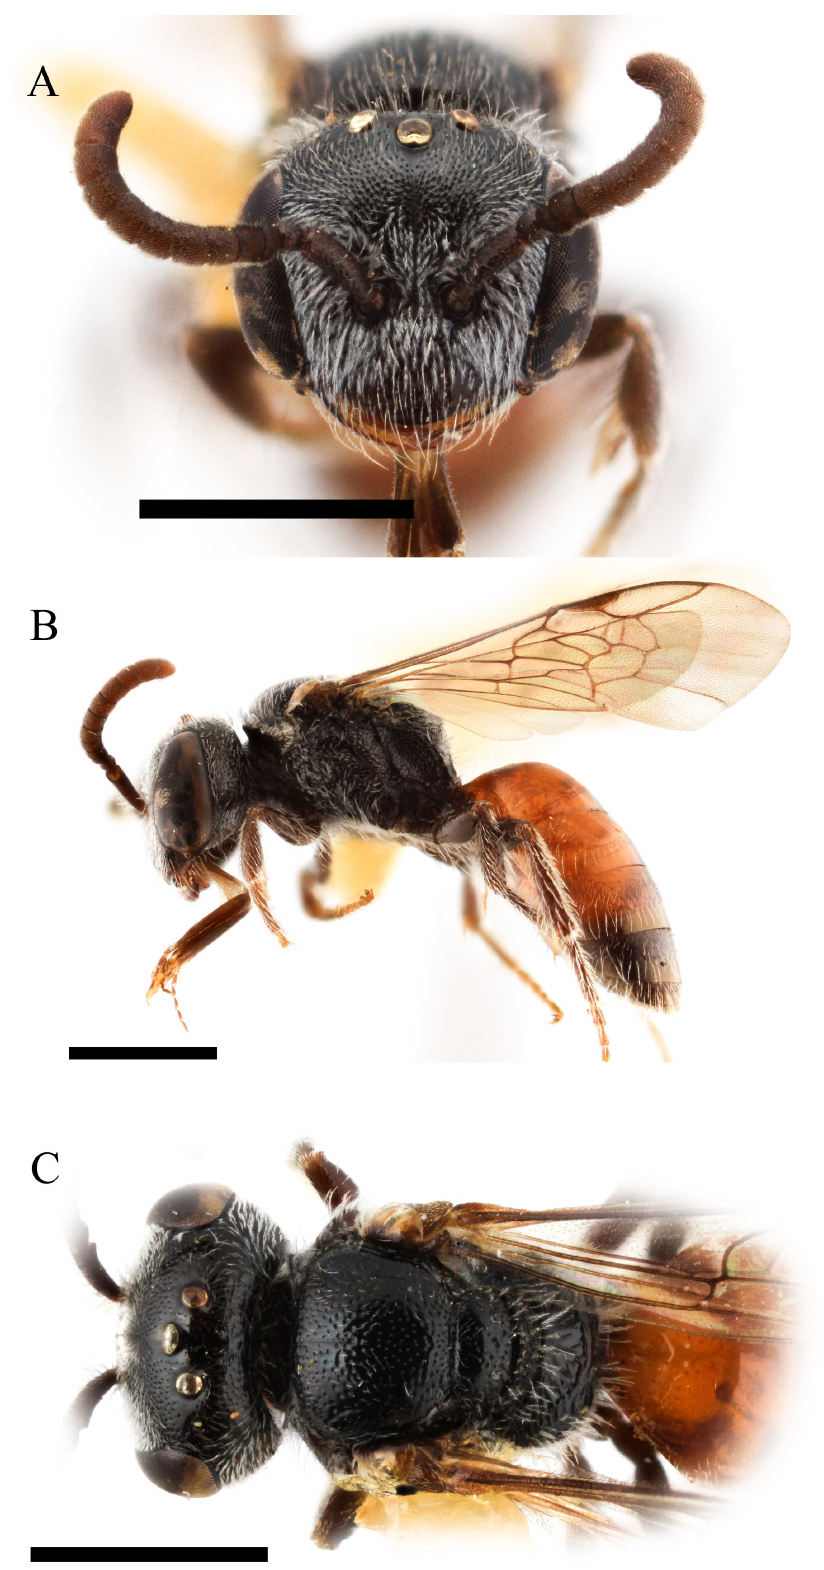
Fig. 12. Sphecodes albifacies sp. nov. Paratype, ♀. A . Face. B . Lateral habitus. C . Dorsum of mesosoma. Scale bars = 1